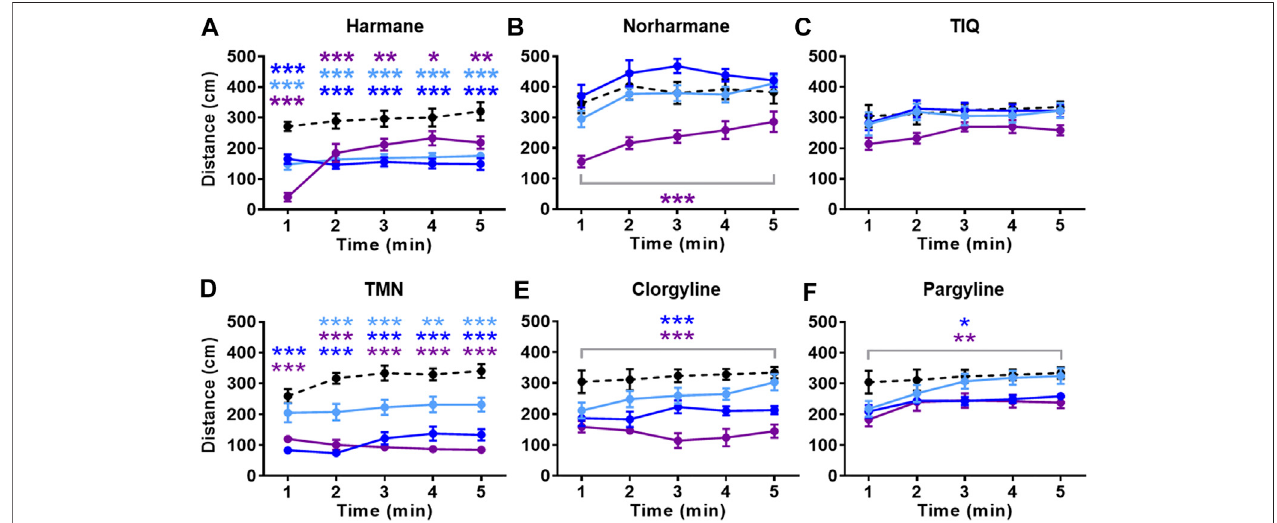
FIGURE 4 | Effects of MAO inhibitors on total distance traveled. Total distance traveled during the NTT is presented for (A) harmane (1, 3, and 10 mg/L) (B) norharmane (0.3, 1, and 3 mg/L) (C) TIQ (10, 30, and 100 mg/L) (D) TMN (3, 10, and 30 mg/L) (E) clorgyline (10, 30, and 100 mg/L), and (F) pargyline (10, 30, and 100 mg/L).Blackdashedline (cid:1) vehiclecontrol;lightblue (cid:1) lowestconcentration;blue (cid:1) middleconcentration;purple (cid:1) highestconcentration.Thesamplesizeisdetailed in the legends for Figures 3 , 4 . Data are expressed as mean ± SEM. * p < 0.05; ** p < 0.01; *** p < 0.001. Abbreviations: NTT (cid:1) novel tank test; TIQ (cid:1) 1.2,3,4- tetrahydroisoquinoline; TMN (cid:1) 2,3,6-trimethyl-1,4-naphthoquinone.